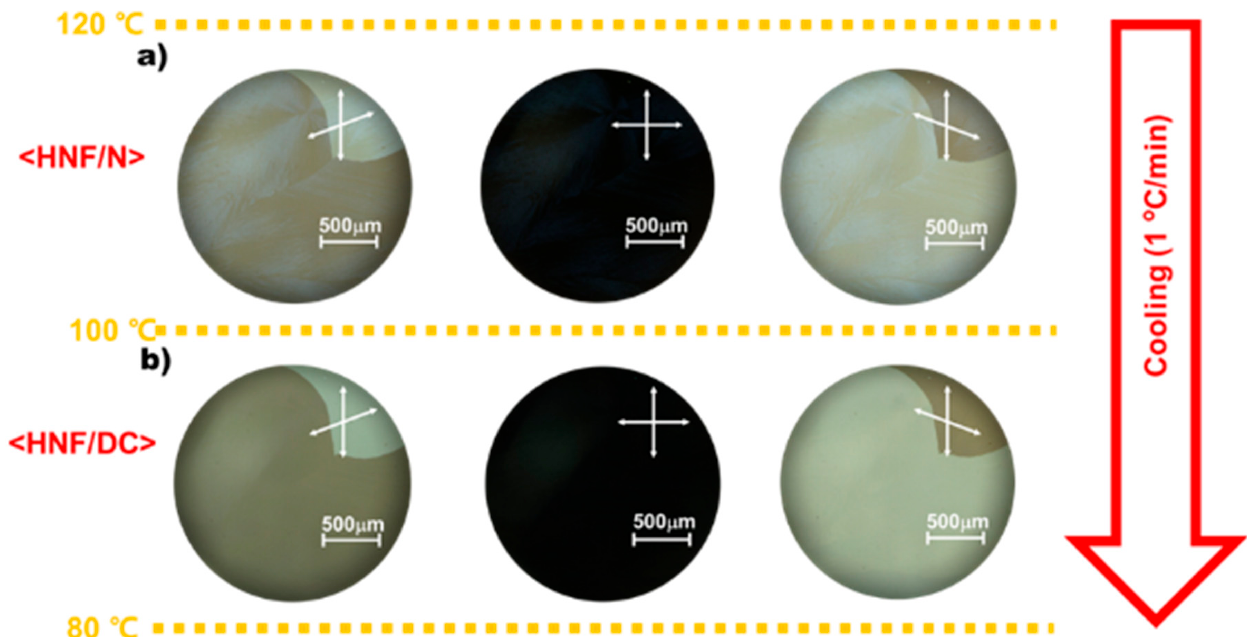
Figure 3. Typical POM images of ( a ) <HNF/N> and ( b ) <HNF/DC> appearing in M1 cooled at 1 °C min − 1 . The arrows indicate the polarizer orientations.